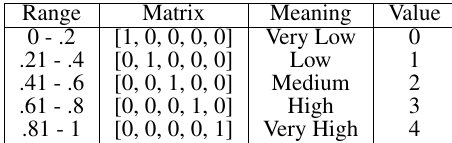
Table 1. Source: Own creation. Labeled ranks use to categorized the results from the perception tests.